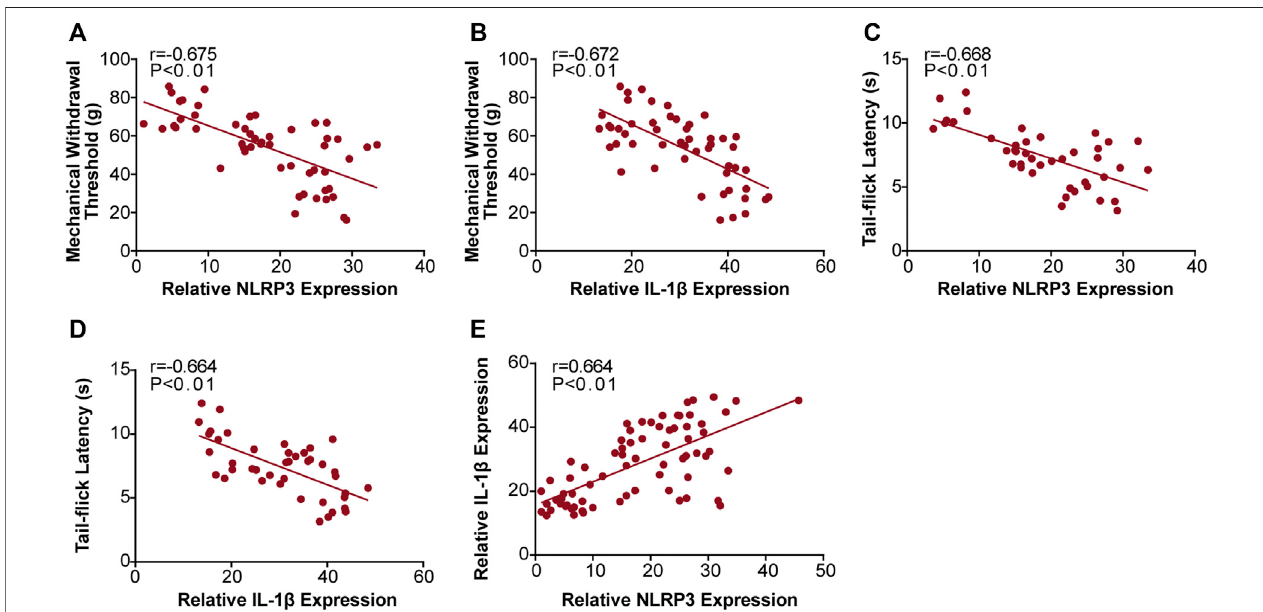
FIGURE6| CorrelationanalysisbetweenthebehavioralphenotypesandNLRP3,IL-1 β expressionindiabeticrats.AnalysisofthecorrelationsbetweenMWTlevels and NLRP3,IL-1 β expression (A) r(NLRP3/MWT) (cid:1) − 0.675 and (B) r (IL-1 β /MWT) (cid:1) − 0.672.CorrelationanalysisbetweenTFLlevels and NLRP3, IL-1 β expression (C) r (NLRP3/TFL) (cid:1) − 0.668 and (D) r (IL-1 β /TFL) (cid:1) − 0.664. Analysis of the correlations between NLRP3 and IL-1 β expression (E) r (NLRP3/IL-1 β ) (cid:1) 0.664. r: correlation coef fi cient.